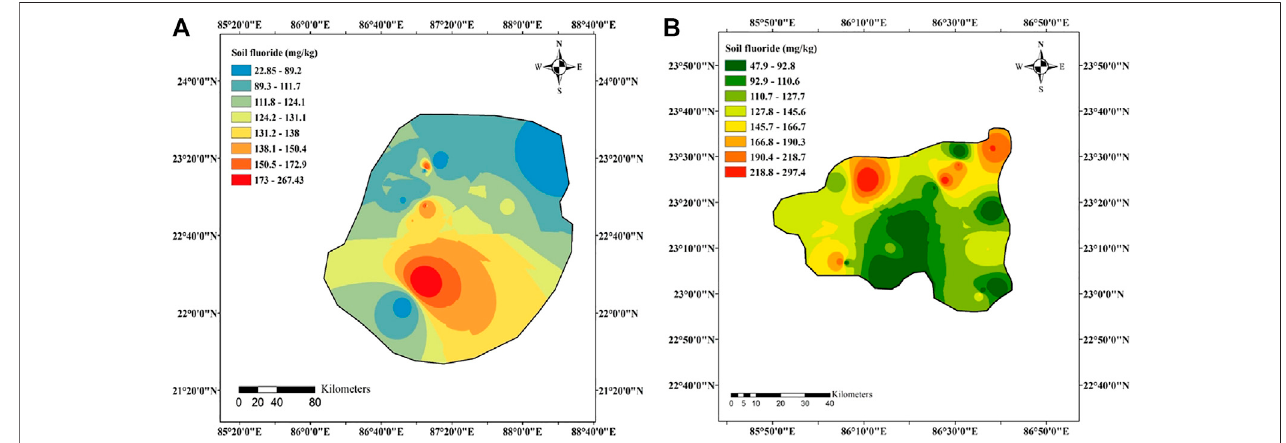
FIGURE 2 | Spatial distribution of fl uoride concentration in soil from (A) eight blocks of Bankura district and (B) 14 blocks of Purulia district.